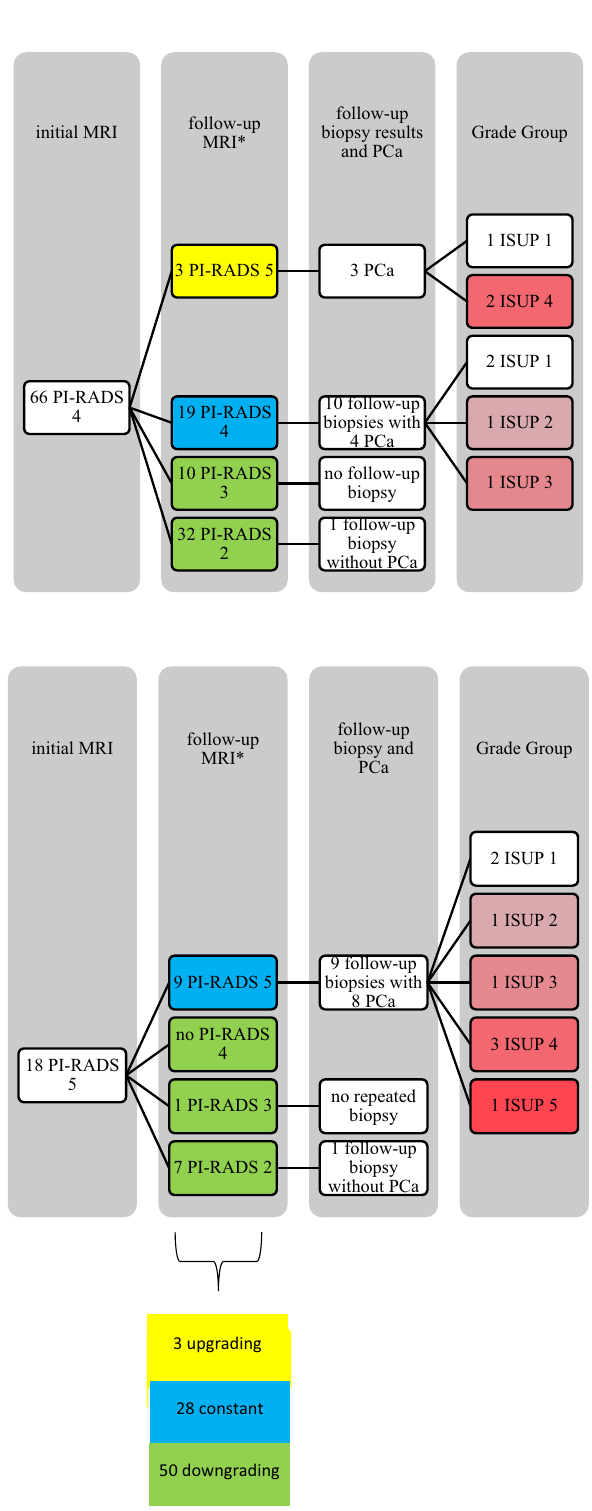
Figure 3. Relation of initial MRI and follow-up MRI, the allocation to a follow-up biopsy and the resulting ISUP Grade. (*on follow-up three PI-RADS Scores